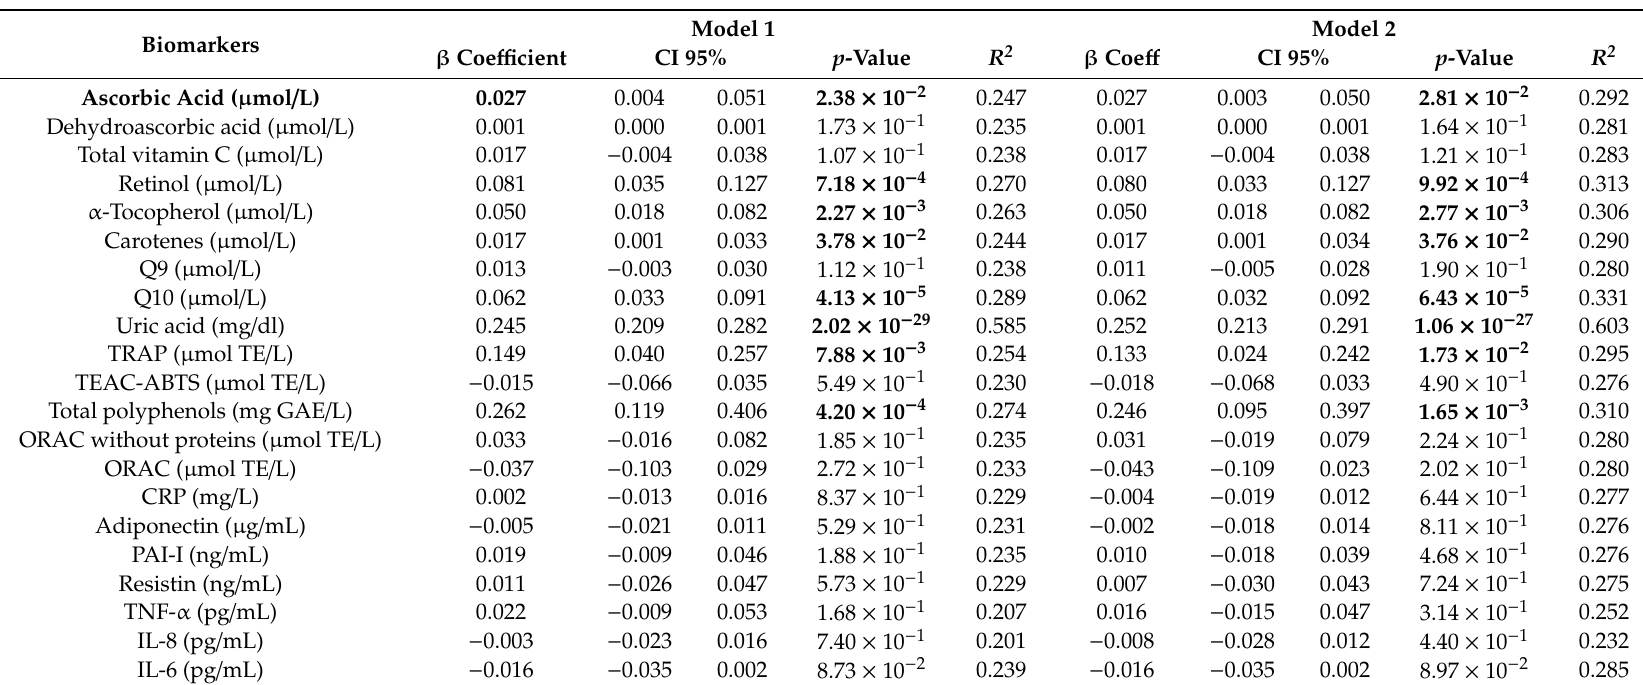
Table 4. Association between P-NEAC as FRAP and the nutrient / inflammation biomarkers in the EPIC Granada–Gipuzkoa cohort sub-sample ( n = 210).